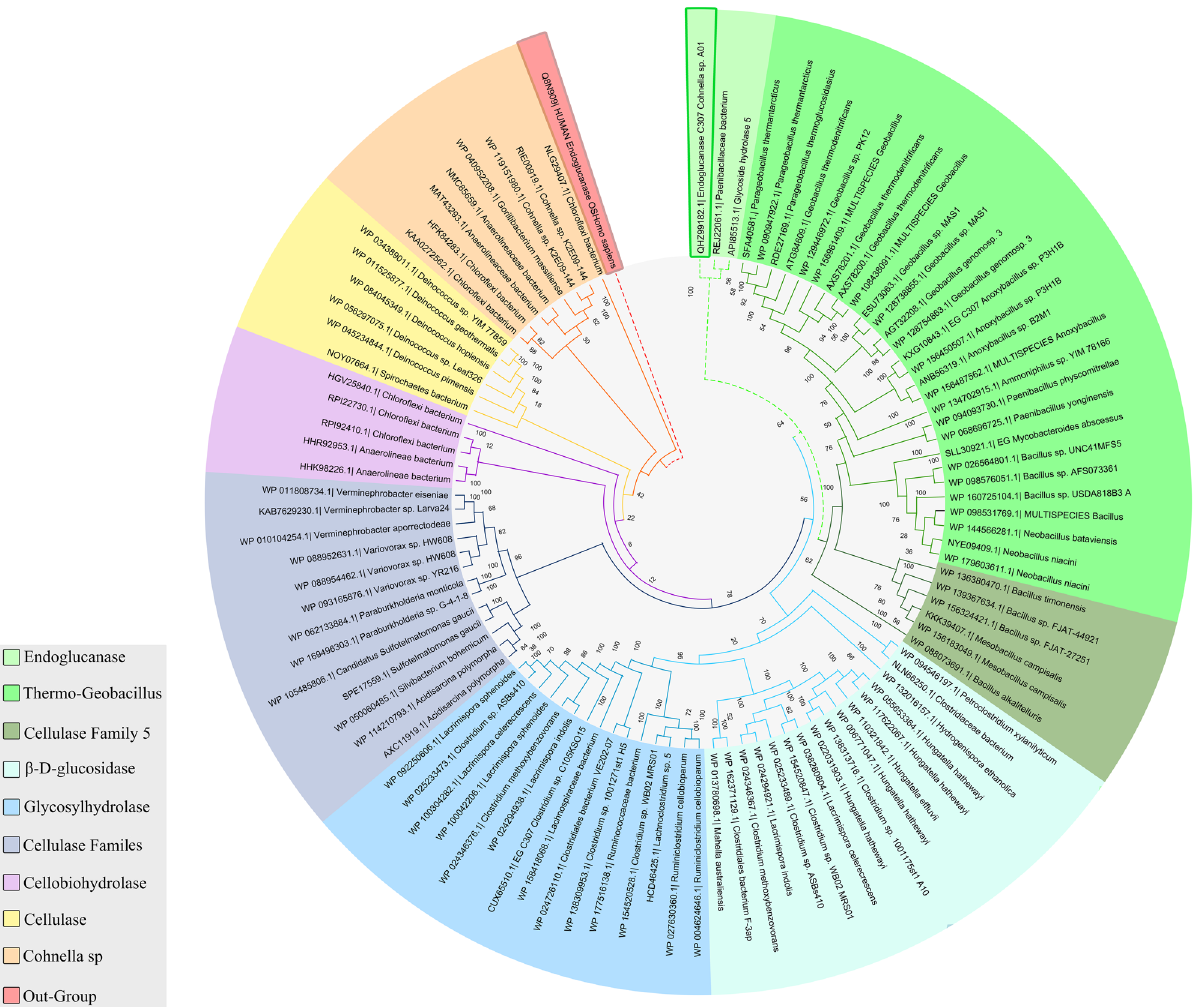
Figure 2. Phylogenetic analysis of CelC307. Unrooted circular phylogenetic tree of CelC307 from Cohnella sp. A01. The tree was constructed using MEGA 8.0 with the neighbor-joining method and it was modified and painted by Adobe Illustrator CS6. The CelC307 is marked with a green rectangle. Human endoglucanase (UniProt accession No. Q8N909) was used as the outgroup and is marked with a red rectangle. The color-coded branches correspond to the significant